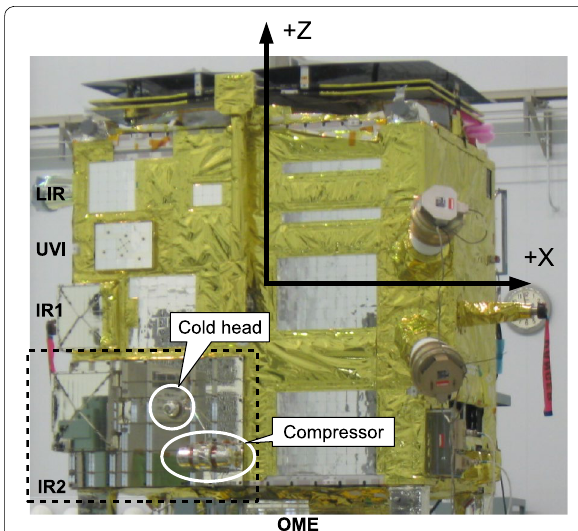
Fig. 1 Location and orientation of IR2 on the spacecraft body. Although direct solar illumination of the spacecraft fully avoided, the IR2 compressor and cold head, slightly elevated from the panel surface, are subject to sunlight. This reduces the efficiency of the cooling performance when the sunlight is incident from the X‑ or Z‑direction in the XZ − −